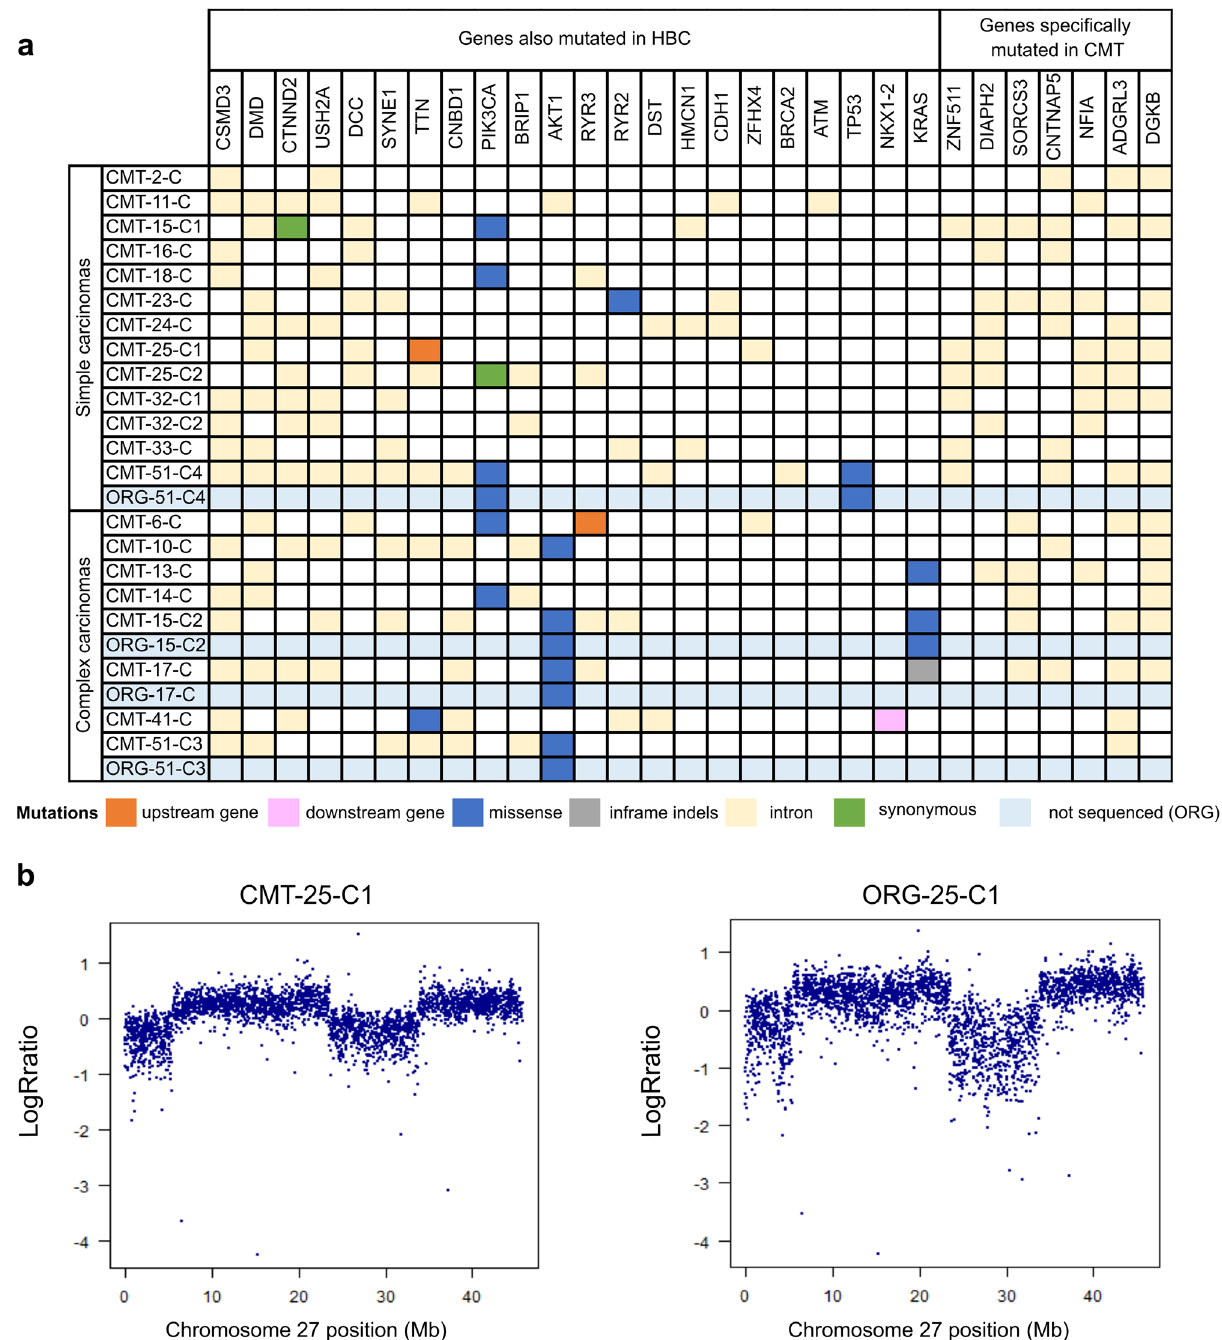
Figure 3. The genetic landscape of CMT is conserved in patient-derived organoids. ( a ) Overview of somatic mutations of 21 CMTs for 29 mutated genes, with differentiation between simple and complex carcinomas. Six mutation types are represented according to the color legend. Point mutations of the corresponding organoids for the mentioned gene ( PIK3CA , AKT1 , TP53 , KRAS ) are represented (light blue lines). ( b ) Log R ratios markers on chromosome 27 for matched pair CMT-25-C1/ORG-25-C1. Note the conservation of the copy number variation in the organoid line. See also Supplementary Figure